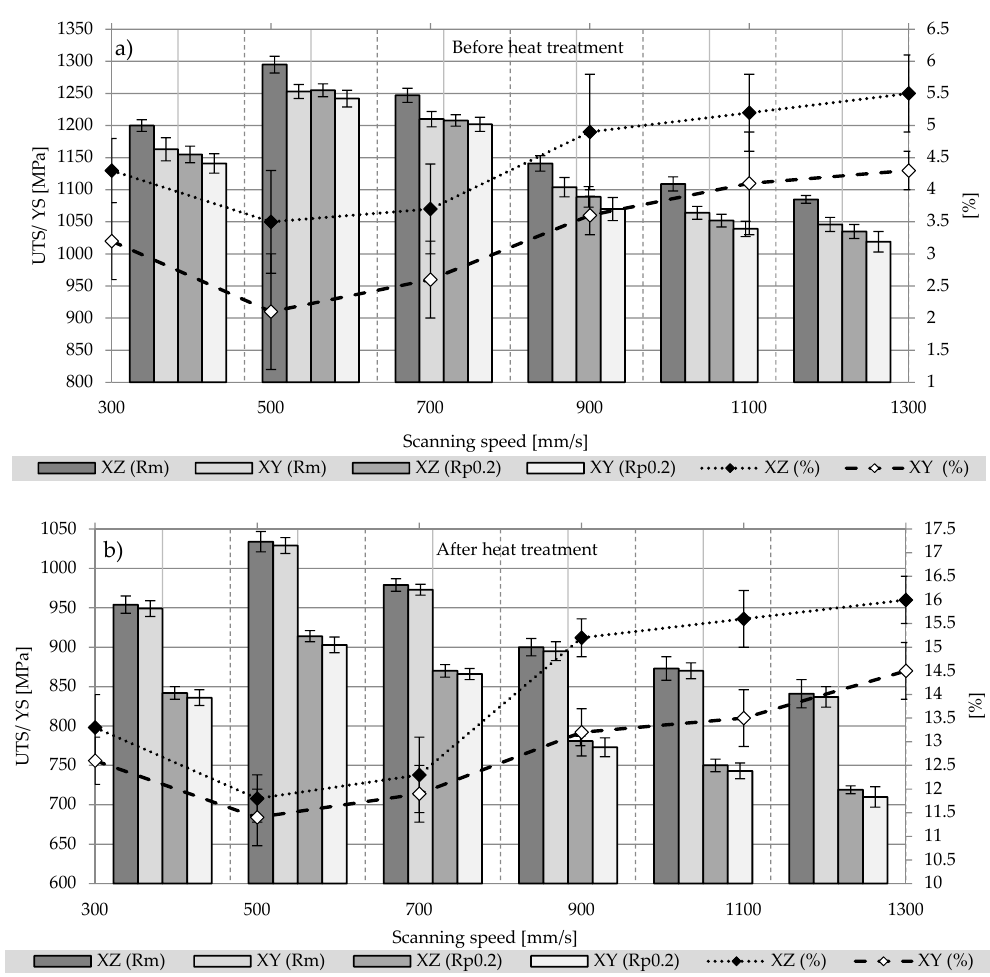
Figure 6. Mechanical properties of Ti6Al4V samples vertically (XZ) and horizontally (XY) oriented to the building direction before ( a ) and after ( b ) heat treatment.